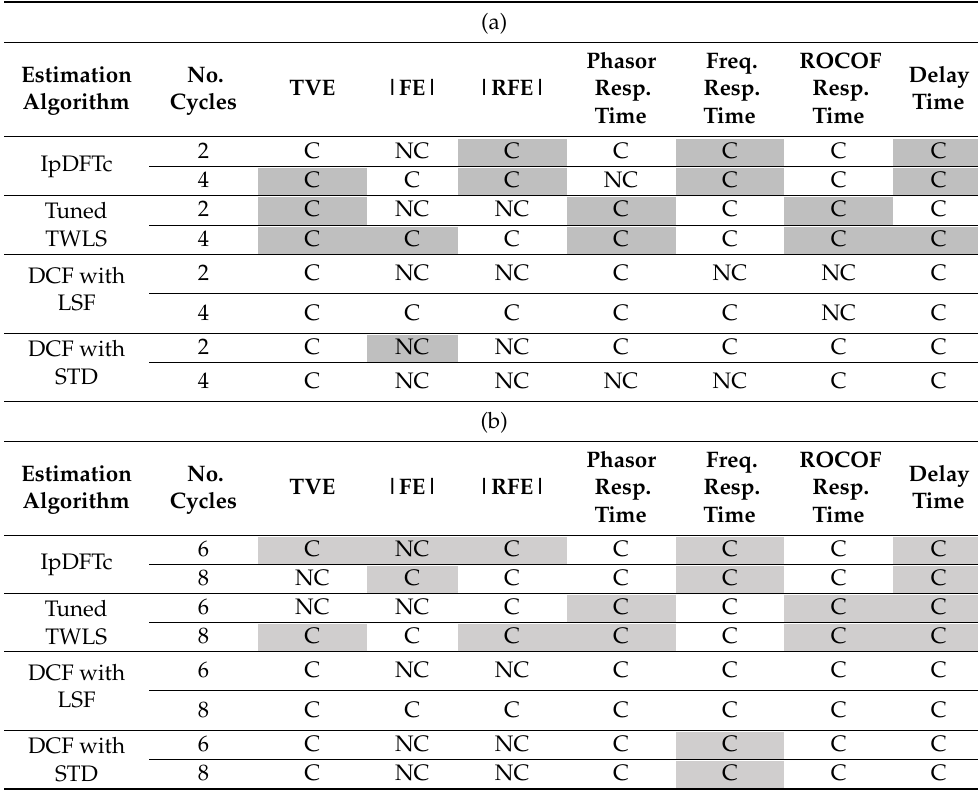
Table 8. Overall comparison between the IpDFT-tuned estimation algorithms under study in the P Class (a) and M Class (b) PMU testing conditions reported in the IEEE/IEC Standard